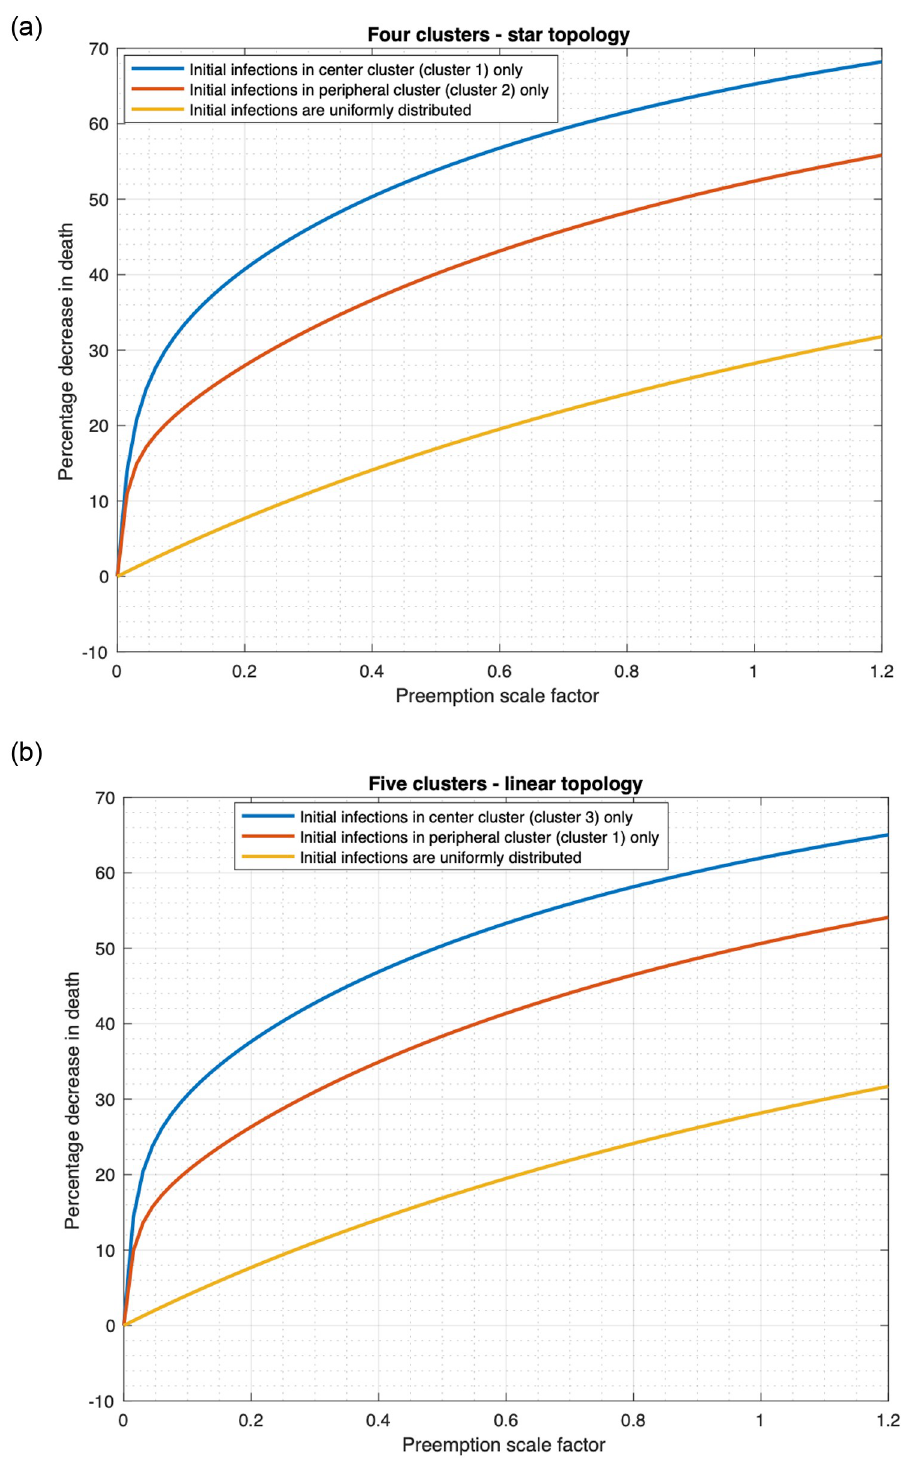
Fig 11. Percentage decrease in fatality as a function of preemption scale factor. a) Star topology. (b) Linear topology.